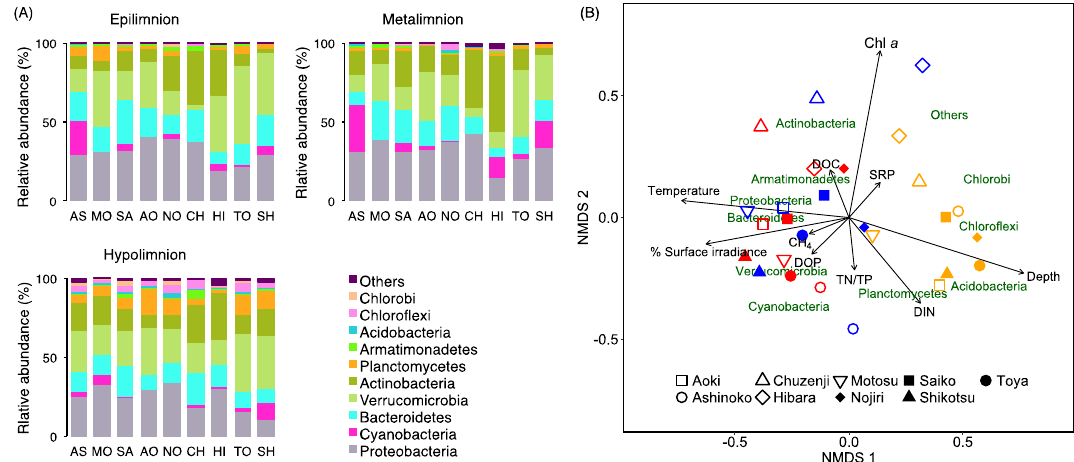
Figure 4. Taxonomic composition of bacterioplankton in the study lakes revealed by 16S rRNA amplicon sequencing analyses ( A ) and the result of non-metric multidimensional scaling (NMDS_ analysis for the relationship between lake physicochemical variables and the community composition of planktonic bacteria ( B ). See the legend for Figure 2 for the abbreviations of lake names appearing in panel (A). Red, blue and orange symbols refer to the bacterioplankton samples obtained from the epilinmion, metalimnion, and hypolinmion, respectively.